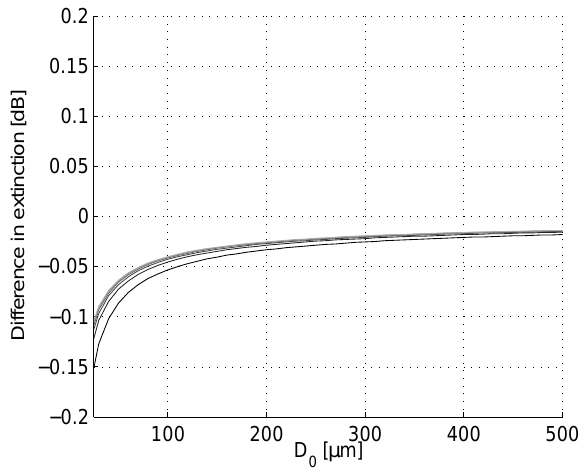
Fig. 2. Colour ratio as a function of median volume drop diameter D D 0 .